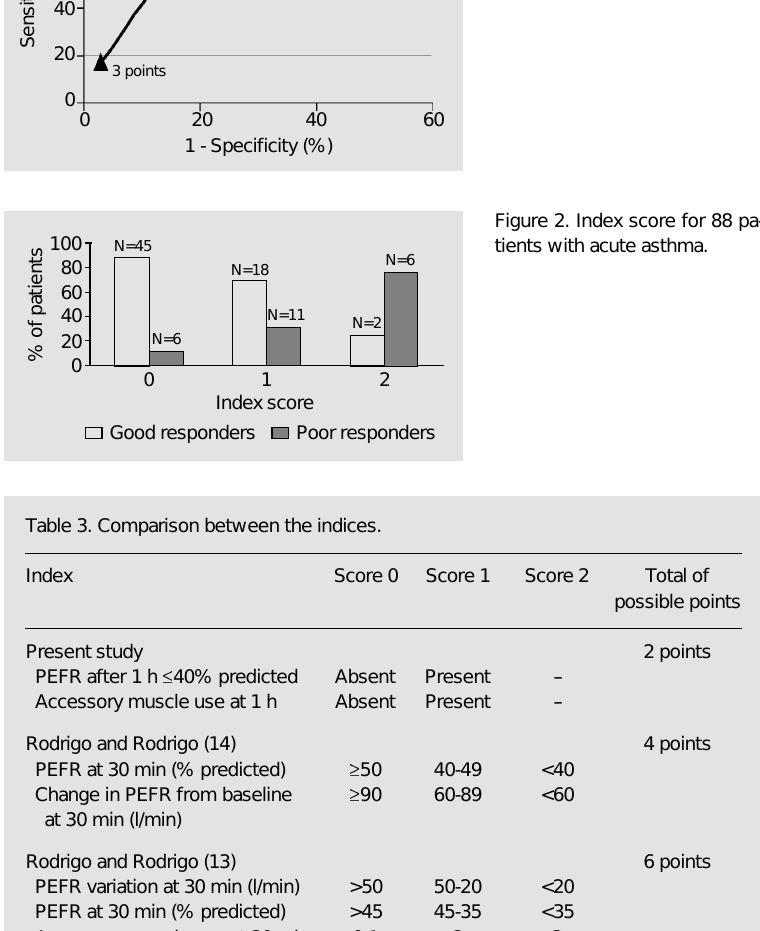
Figure 2. Index score for 88 pa- tients with acute